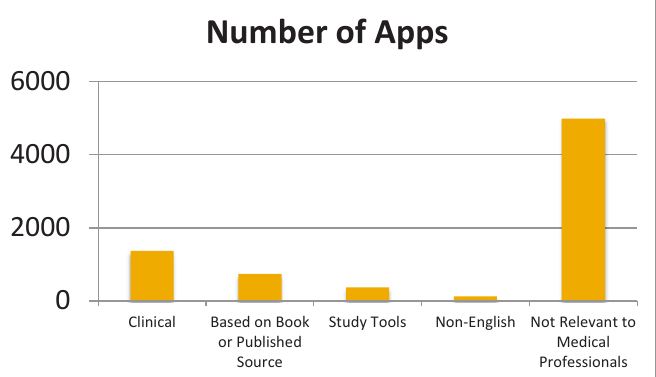
Figure. Number of applications divided into categories